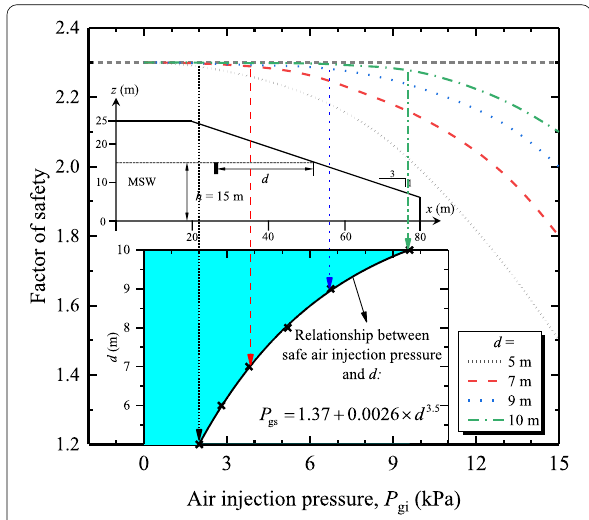
Fig. 10 Variations of FS with air injection pressure P gi for four values of d and the relationship between safe air injection pressure and